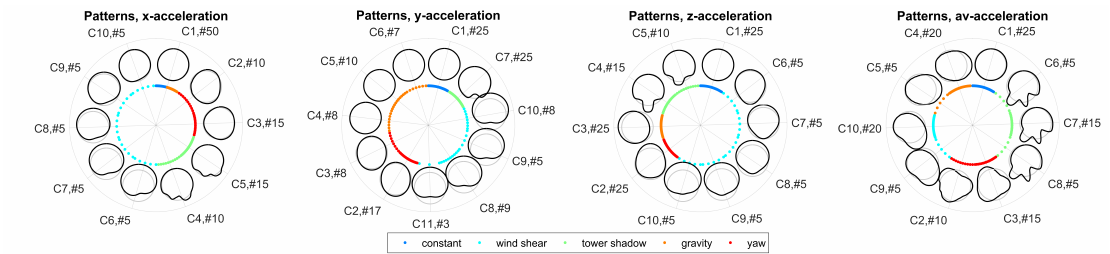
Figure 12. Effect of mounting angles on resulting bending patterns: mounting angles simulated as β and γ varying from − 8° to 8° in 4° steps for a rotation frequency of f 0 = 0.2 Hz. Patterns are displayed along the morphing circle with Ci # j specifying the cluster number i with j members. Bending effects are displayed along the coloured inner